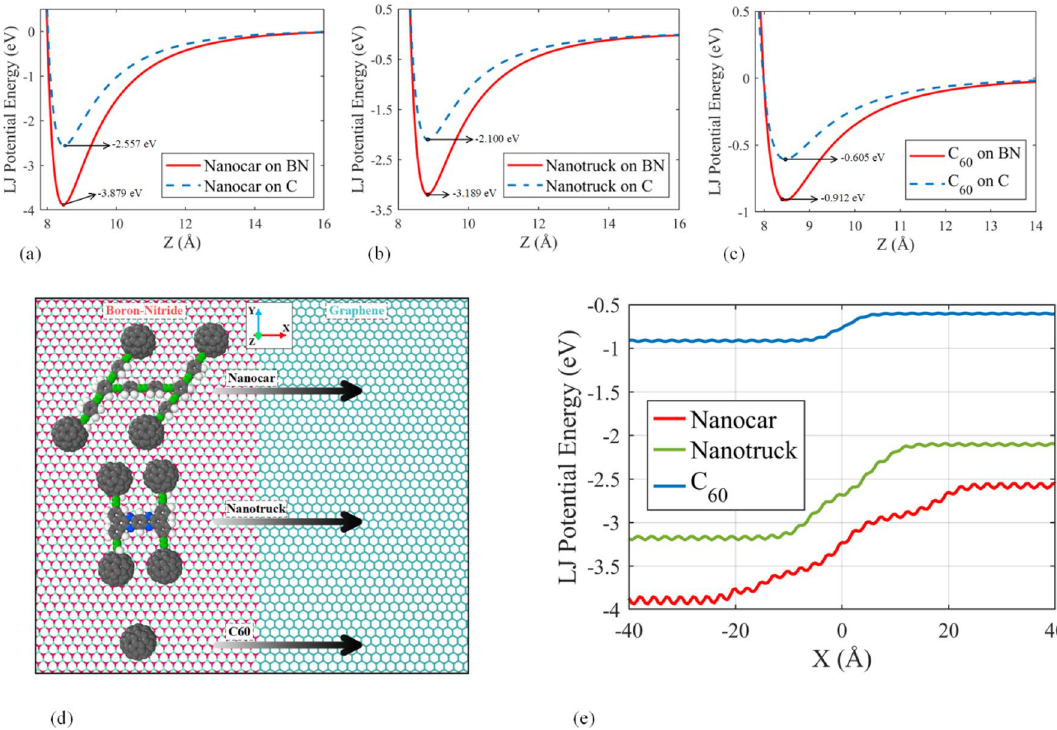
Figure 2. Potential energy as a function of the object’s center of mass vertical distance from the substrate for ( a ) nanocar, ( b ) nanotruck, and ( c ) C 60 . The attractions between all objects and the pure boron-nitride substrate are stronger than those between objects and the pure graphene substrate. ( d ) Schematic representation of the setup considered for evaluation of potential energy when objects pass from pure boron-nitride substrate to pure graphene substrate. The coordinate system is illustrated in the figure. ( e ) The LJ potential energy captured when objects are passed from boron-nitride to